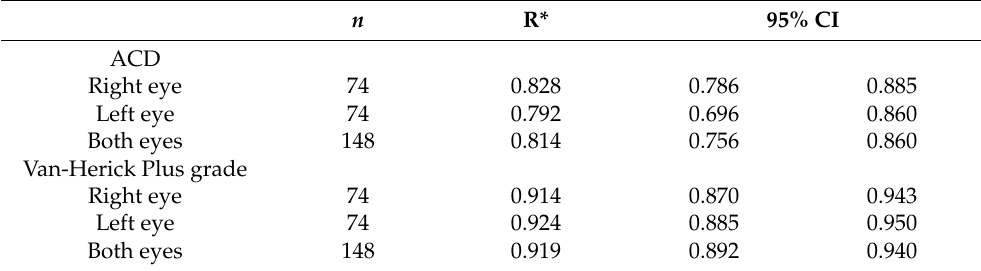
Table 2. Correlation between conventional slit-lamp microscopy findings and SEC